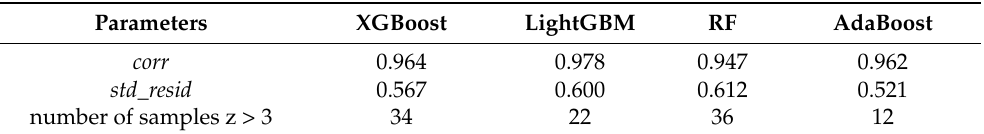
Table 5. The base model prediction performance.